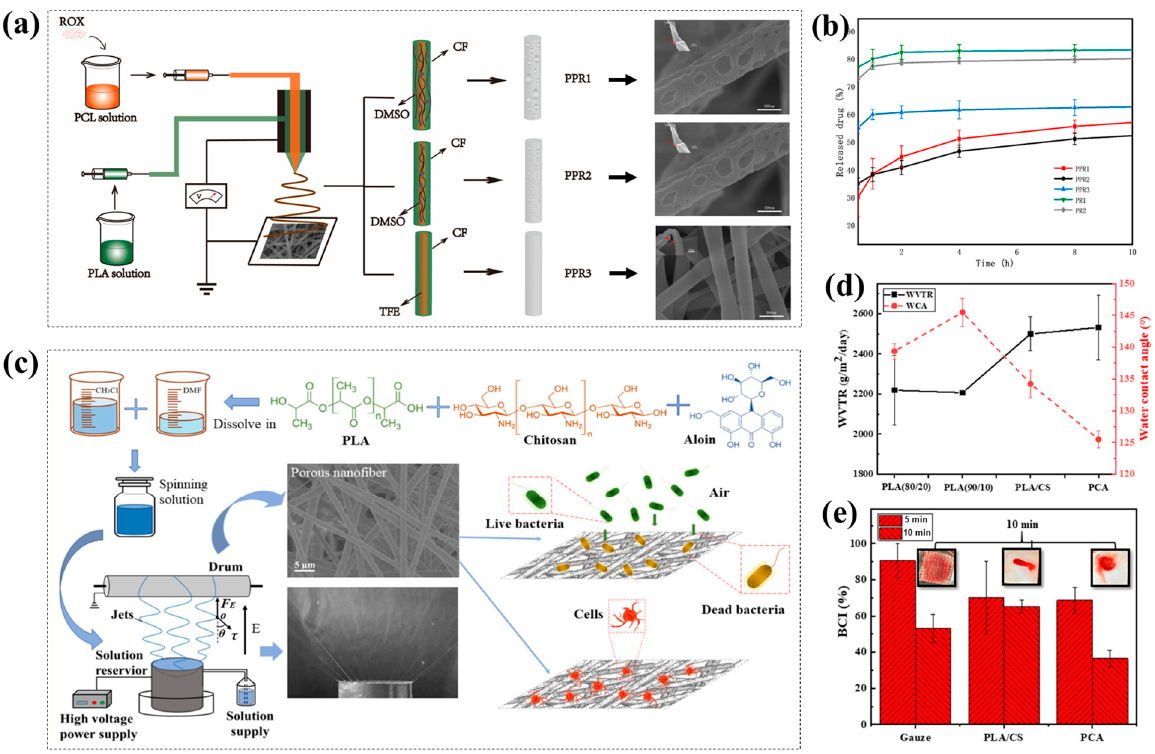
Figure 11. ( a ) Schematic diagram of preparation and SEM images of porous PCL/PLA nanofibers in different core–sheath solvent combinations by coaxial electrospinning method; ( b ) ROX release profiles of different nanofibers over 10 h. Reprinted with permission from Ref. [165], Copyright 2021, MDPI. ( c ) Illustration of the preparation of porous PLA/CS/aloin nanofibers (PCA); ( d ) water contact angles (WCAs) and water vapor transmission rates (WVTRs) of different nanofiber membranes; ( e ) in vitro blood coagulation test of nanofiber membranes. Reprinted with permission from Ref. [73], Copyright 2022, Springer.